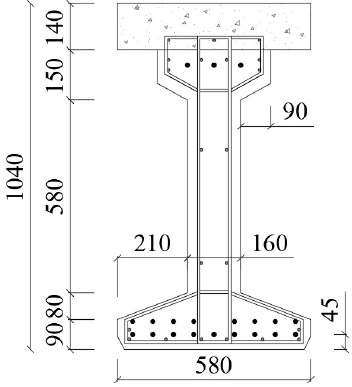
Figure 3. I-beam cross-section (in